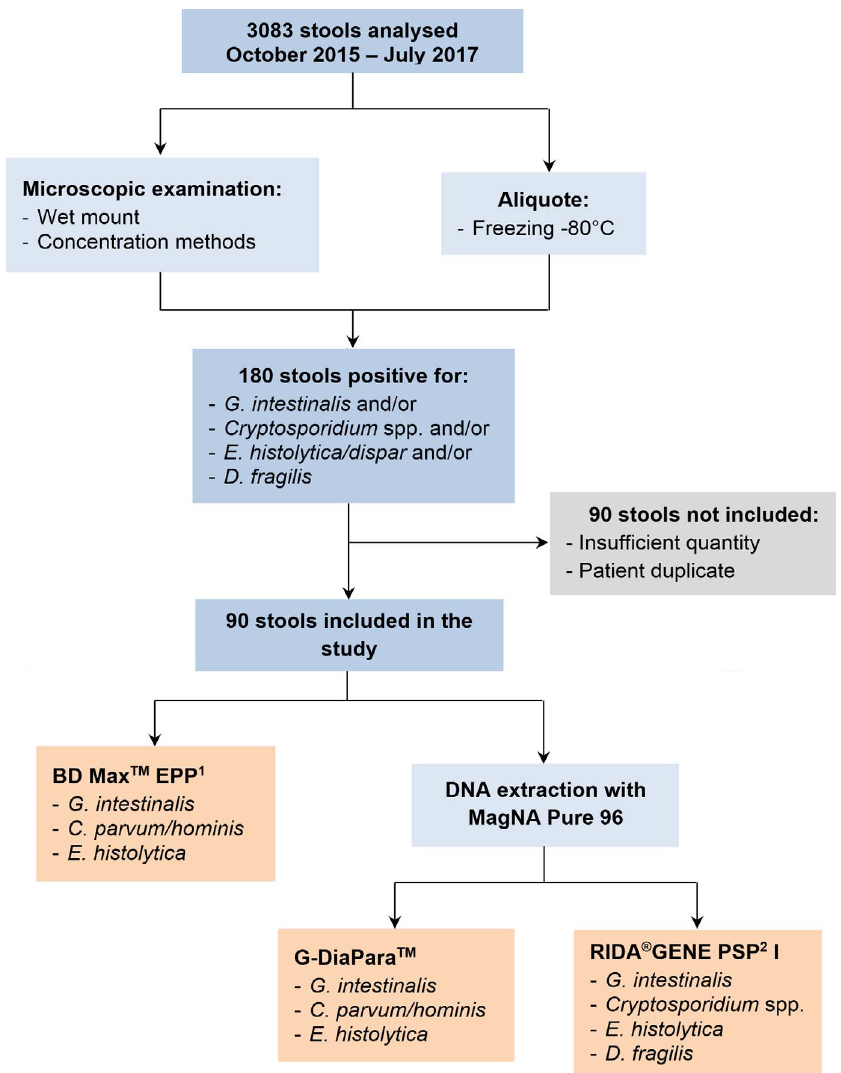
Figure 1. Study flow chart . 1 EPP: Enteric Parasite Panel; 2 PSP: Parasitic Stool